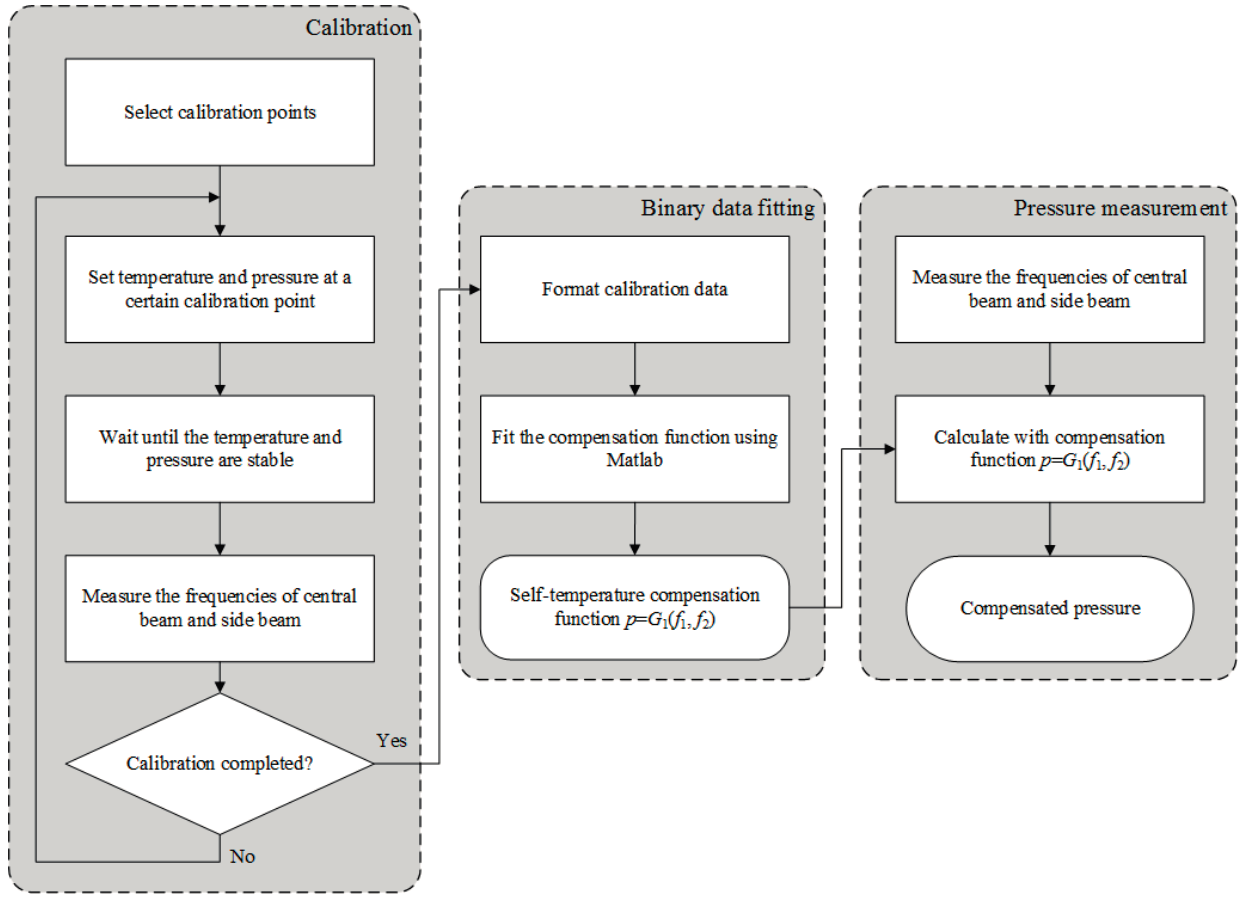
Figure 2. The self-temperature compensation flow chart includes three main steps: Calibration, binary data fitting, and pressure measurement. In the calibration step, the frequencies of the central beam and side beam were measured at each temperature and pressure